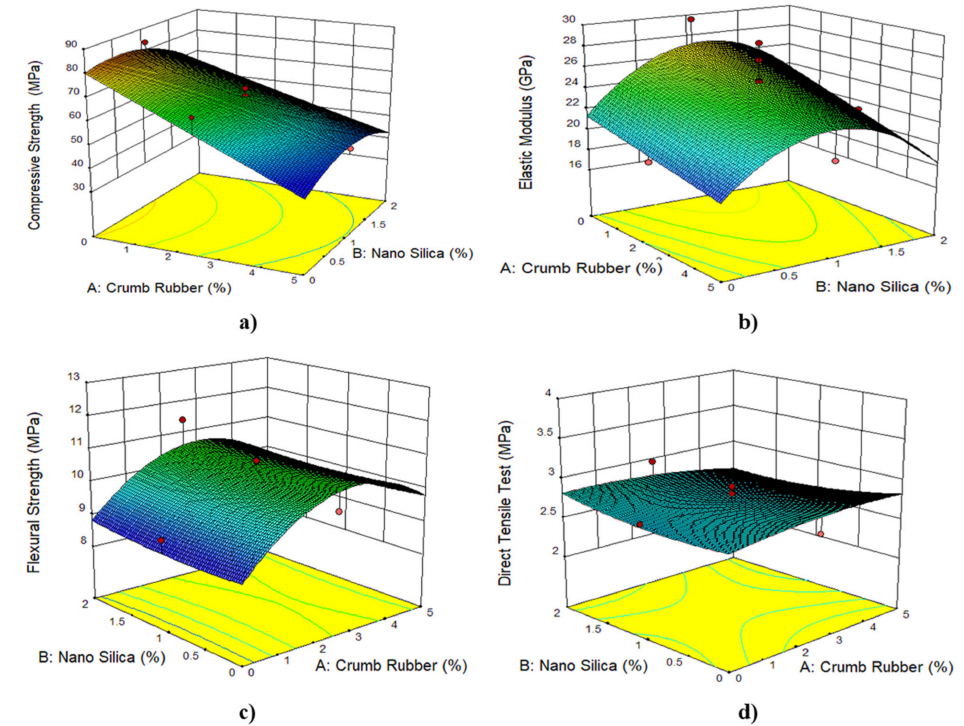
Figure 5. The 3D response surface plots for 50% fly ash and 1% PVA fiber for ( a ) compressive strength, ( b ) flexural strength, ( c ) direct tensile strength, and ( d ) elastic